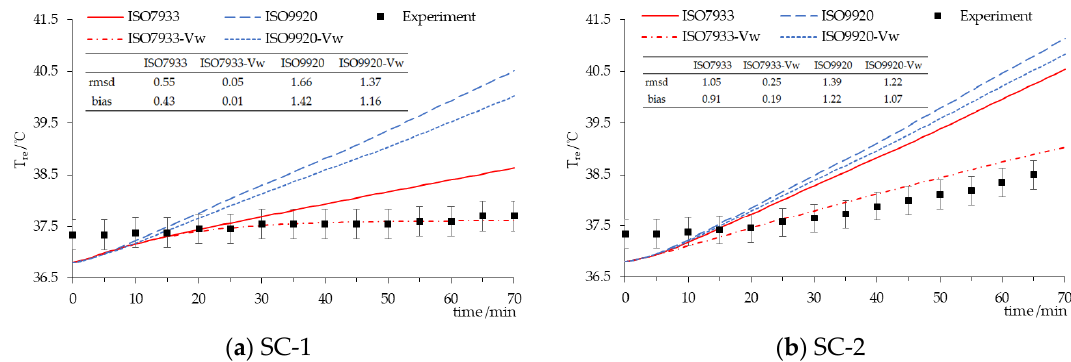
Figure 4. Time-course changes in the rectal temperature for SC. ( a ) clothing insulation 2.01 clo in 30 °C; ( b ) clothing insulation 2.01 clo in 40 °C.